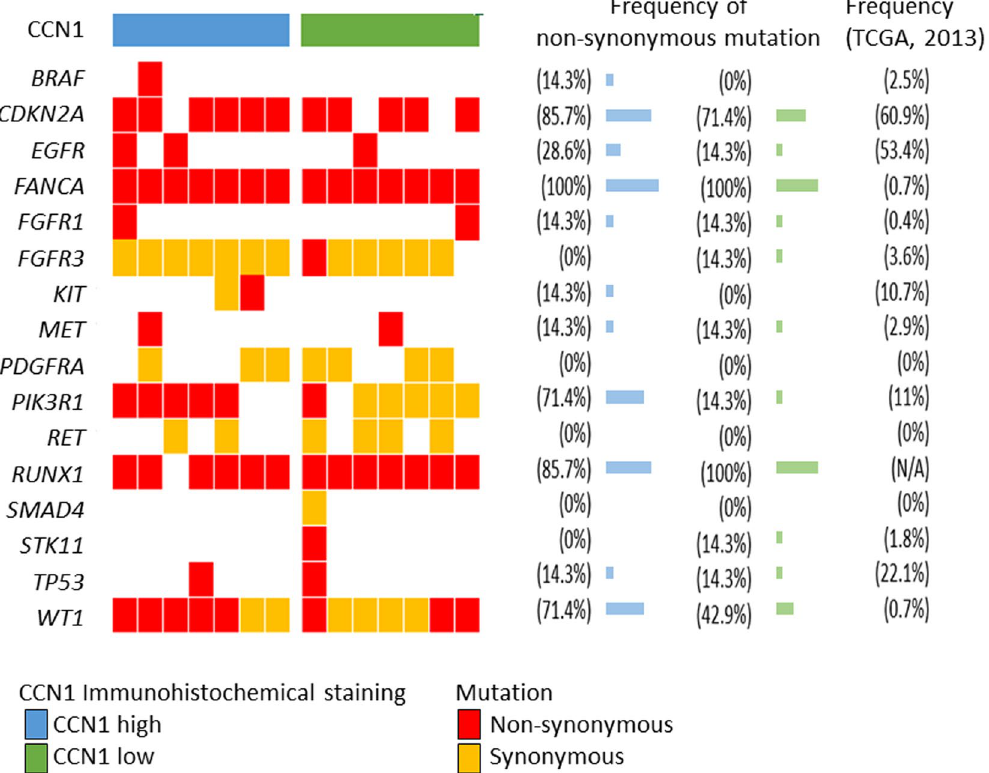
Figure 2. Mutations in high and low CCN1 expression glioblastoma. Left; Specific genes harboring nonsynonymous and synonymous mutations are shown. Middle; The frequency of nonsynonymous mutations in each of the listed genes in both CCN1 groups. Right; The frequency of genetic alterations in each of the listed genes in The Cancer Genome Atlas (TCGA) dataset